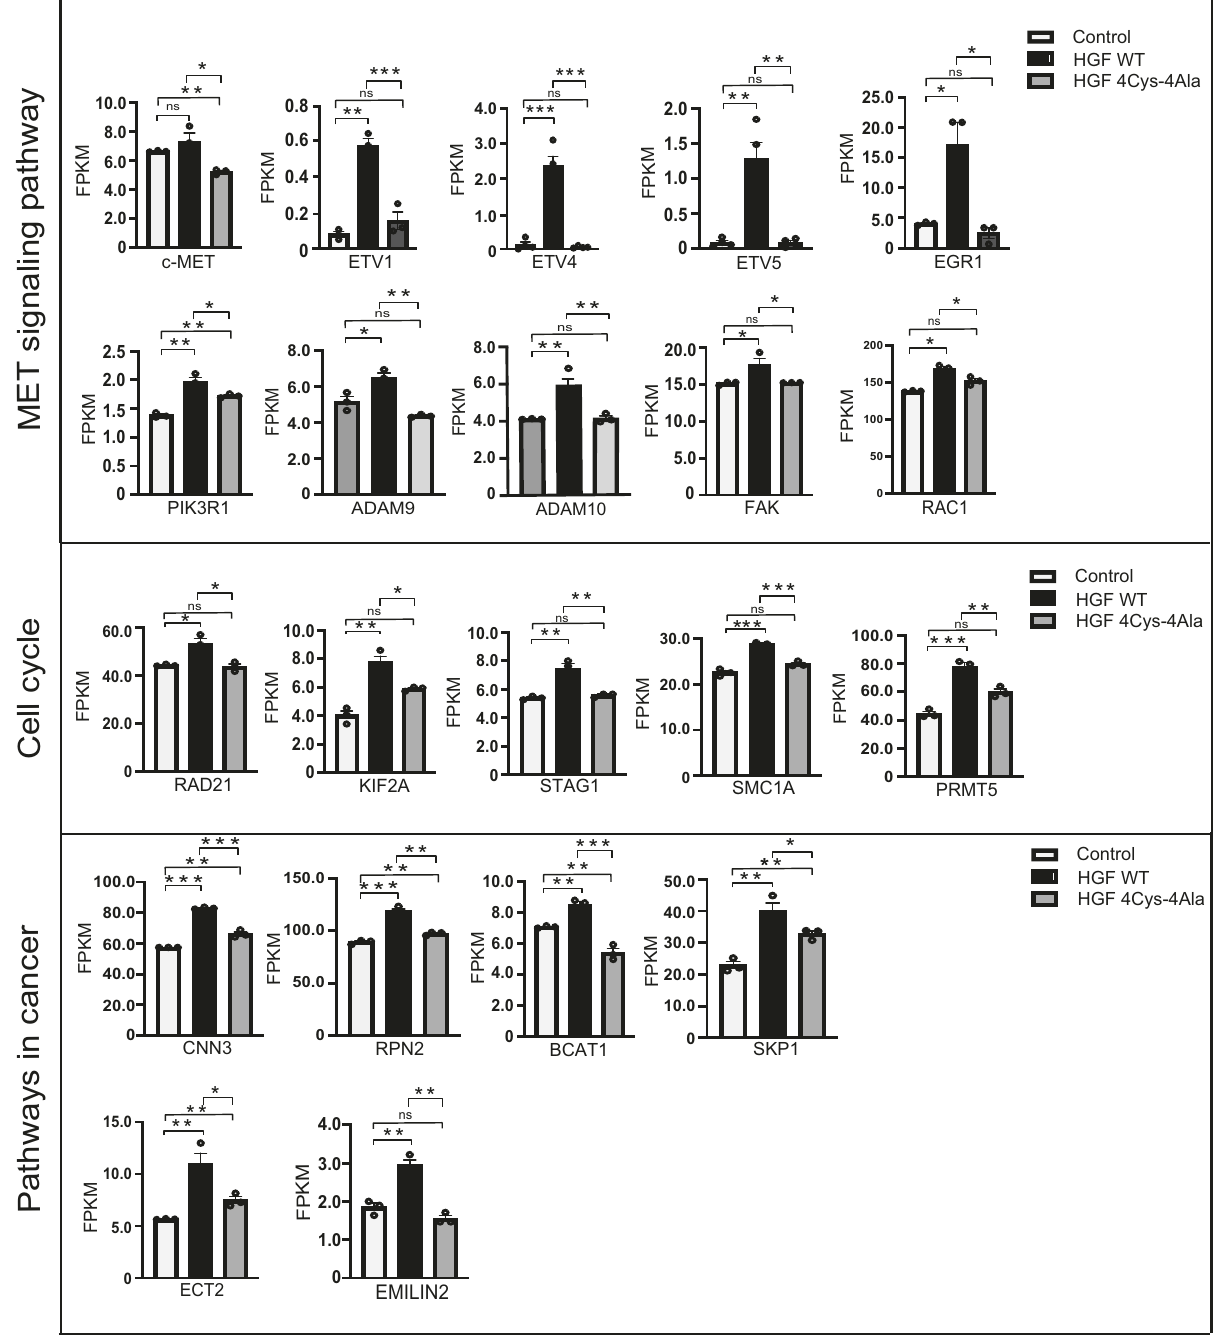
Fig. 4 Transcriptome analysis post HGF stimulation in 293T cells. Differential expression analysis by RNA seq in 293T cells following HGF WT and HGF 4Cys-4Ala treatment as indicated con fi rms that core cysteines in HGF PAN domain are necessary for the expression of a wide range of genes. Responsive genes were normalized to FPKM value for non-treated cells and then normalized to HGF WT treated cells. Data represents the average of three independent biological replicates and * p < 0.05, ** p < 0.005 and *** p < 0.0005 were calculated with a student ’ s